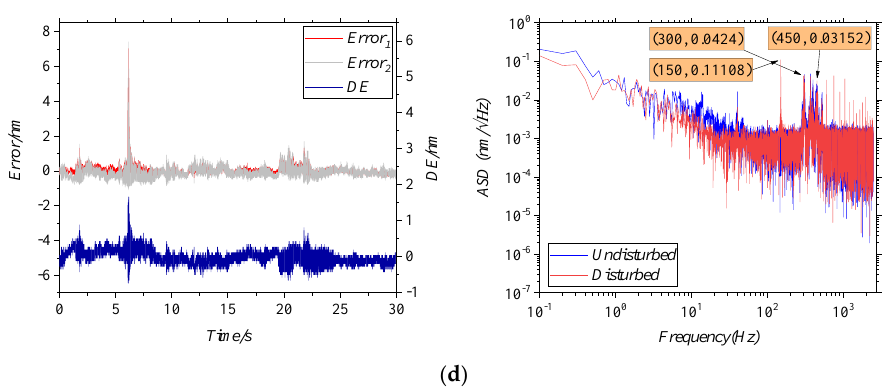
Figure 6. The errors curves for changing the interference angle, ( a ) I AC /I DC = 100%, ( b ) I AC /I DC = 77%, ( c ) I AC /I DC = 62%, ( d ) I AC /I DC = 53%.